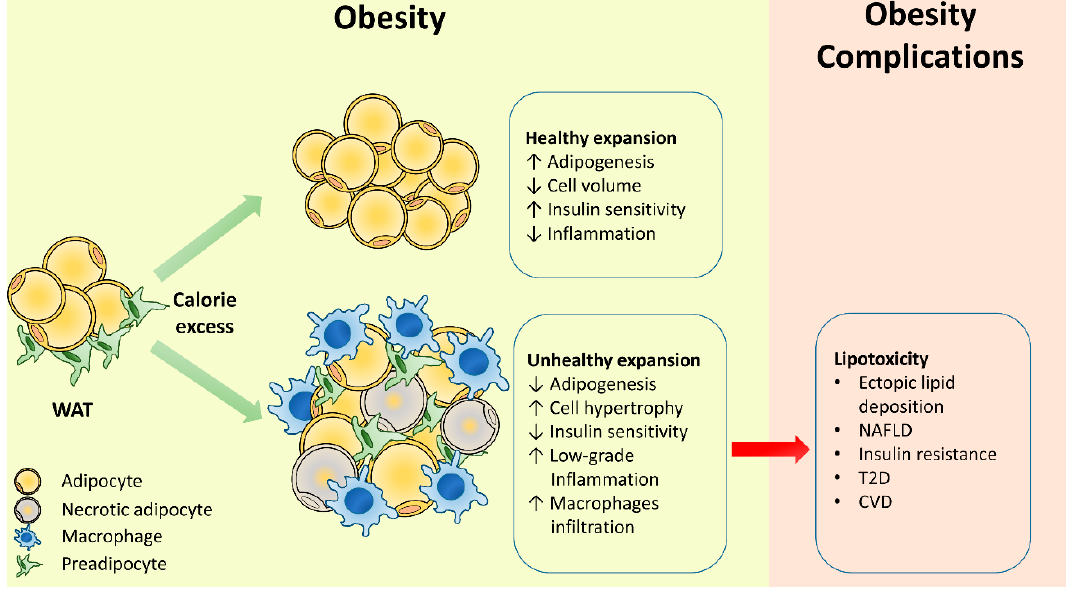
Figure 1. White adipose tissue expansion in obesity. White adipose tissue responds to caloric excess through a healthy or unhealthy expansion. Healthy expansion through adipocyte hyperplasia protects against the metabolic complications of obesity. Unhealthy expansion through adipocyte hypertrophy promotes the obesity-associated metabolic complications. WAT, white adipose tissue; T2D, type 2 diabetes; NAFLD, non-alcoholic fatty liver disease; CVD, cardiovascular disease.